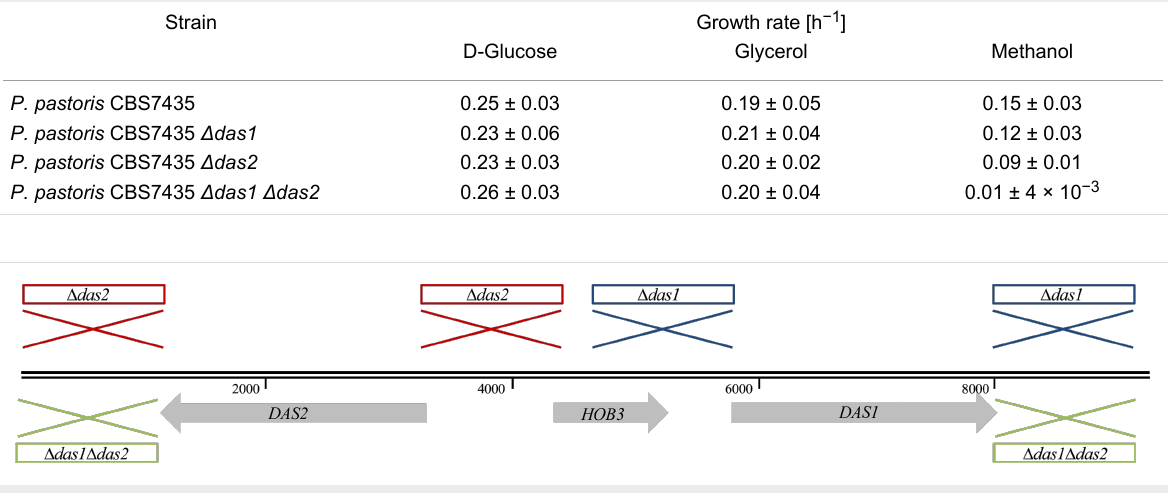
Figure 2: Representation of the genomic region coding for dihydroxyacetone synthases. The DAS1 and DAS2 coding sequences are located in close proximity on chromosome 3 in opposite direction. The two genes are separated by a short sequence encoding a hypothetical guanosine nucleotide exchange factor ( HOB3 ). The target sites for the respective das knock-out cassettes are indicated